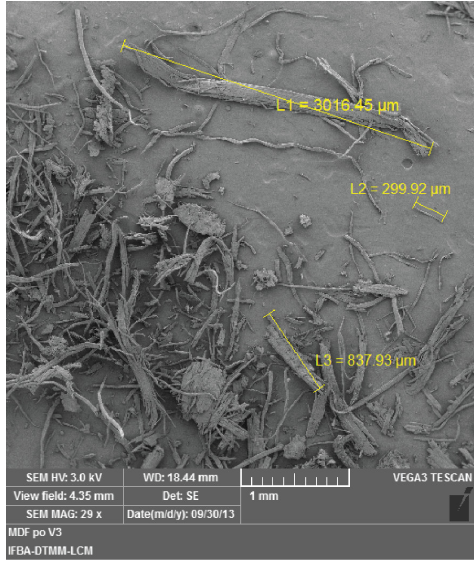
Figure 2. Waste MDF in powder collected in a joinery.